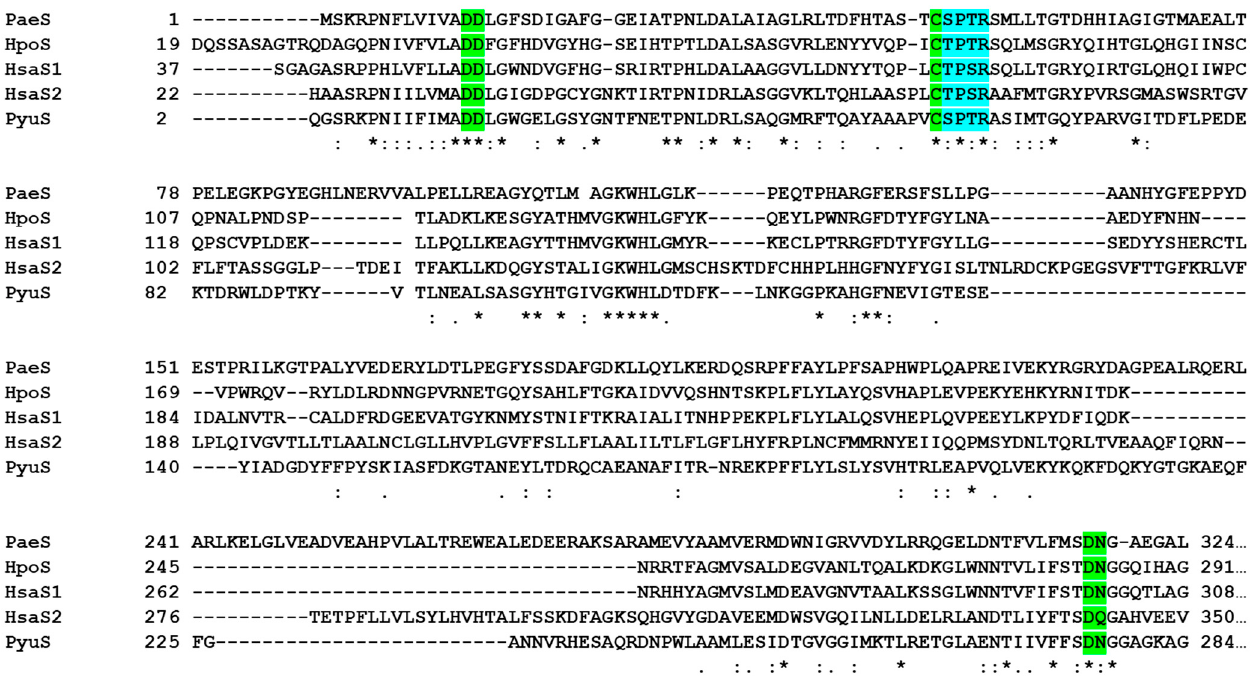
Figure 1. Amino acid sequence alignment of sulfatases from P. aeruginosa (PaeS), H. pomatia (HpoS), H. sapiens (HsaS1 and HsaS2), and P. yulinensis (PyuS). Residues involved in binding calcium are highlighted in green, and the conserved CXPXR sulfatase motif (Cys to FGly post-translational modification) is highlighted in teal. HpoS residues for metal binding are based on homology as there is no crystal structure available for this protein. N-terminal signal peptides or putative signal peptides were removed from the alignment where applicable. * Indicates completely conserved